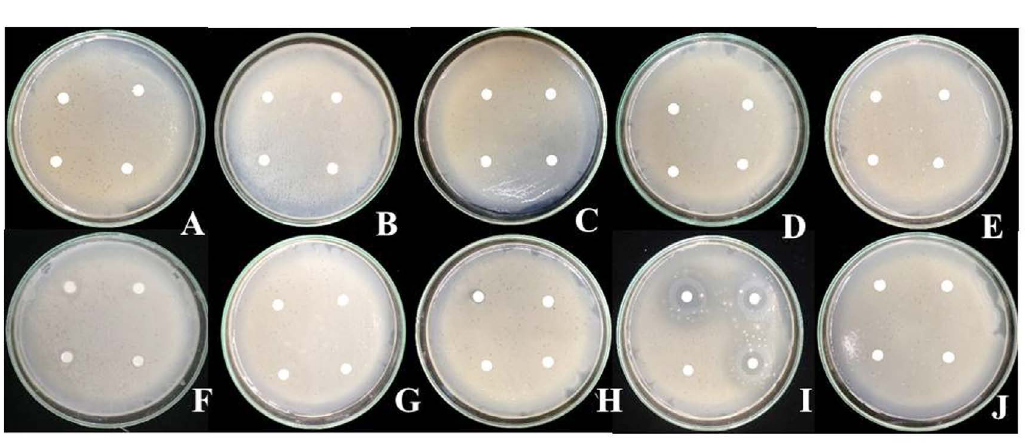
Fig. 2. Compatibility test of antagonistic bacteria Bacillus sp. IKM1 and pesticides A: pyridaben 20% WP, B: imidachloprid 70% WG, C: carbosulfan 20% W/V EC, D: sulfur 80% WG, E: abamectin 1.8% W/V EC, F: etridiazole 6% + quintozene 4% W/V